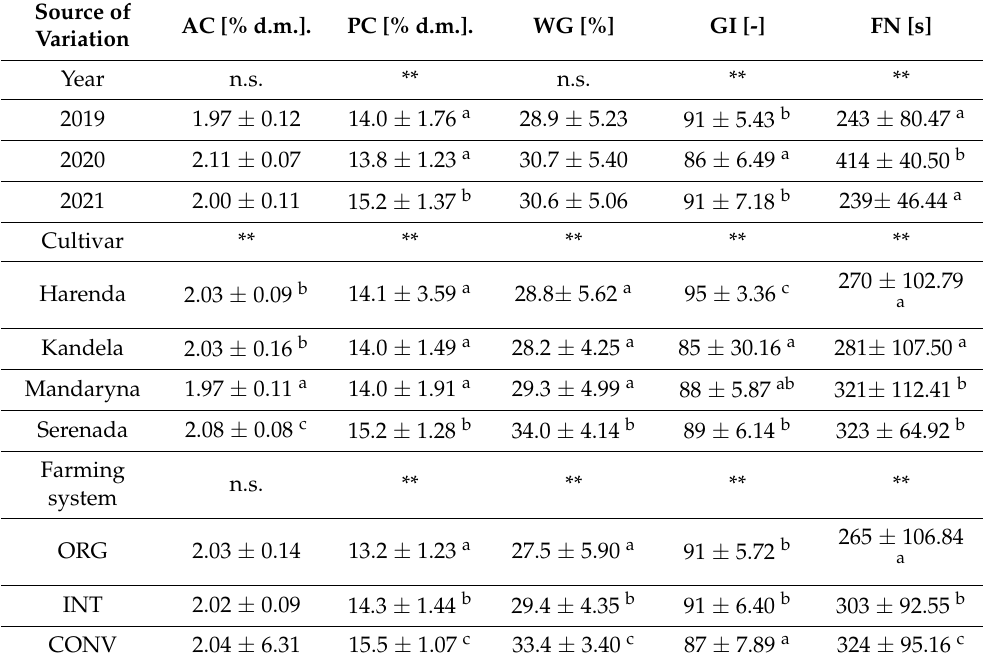
Table 2. The effect of year, cultivar, and farming system on the chemical and rheological properties of wheat grain. Source of AC [% d.m.]. PC [% d.m.]. WG Variation